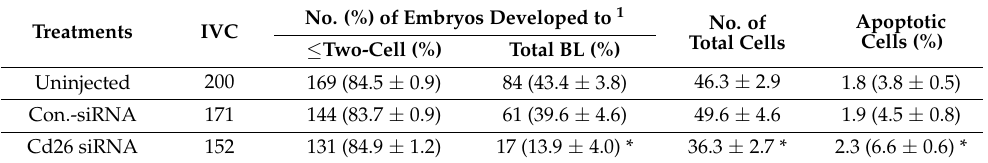
Table 3. Development of porcine parthenogenetic embryos after injection with cd26 siRNA in the oocytes. Treatments IVC